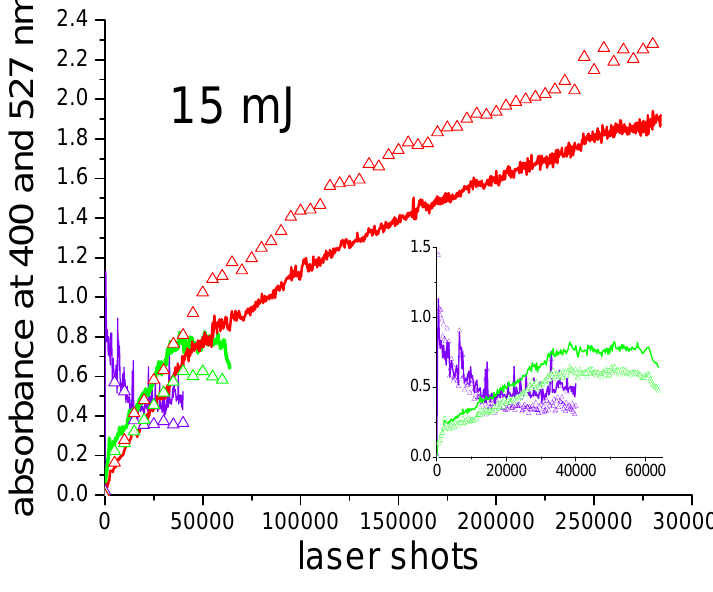
Figure 7. Absorbance at 400 nm (solid lines) and 527 nm (triangles) versus laser shots, during production of PAMAM G5-capped AuNPs with 15 mJ pulses at 1,064 nm (red), 532 nm (green) and 355 nm (violet). The inset shows a magnification of the zone corresponding to 0-60,000 laser shots. Fluence is 1 J/cm 2 and OPL = 1